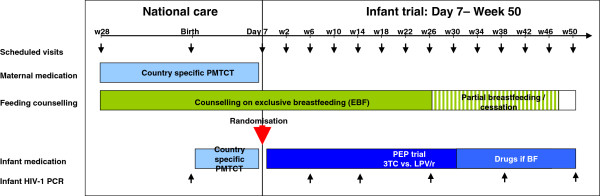
ANRS 12174 PROMISE-PEP trial design including scheduled follow-up visits.